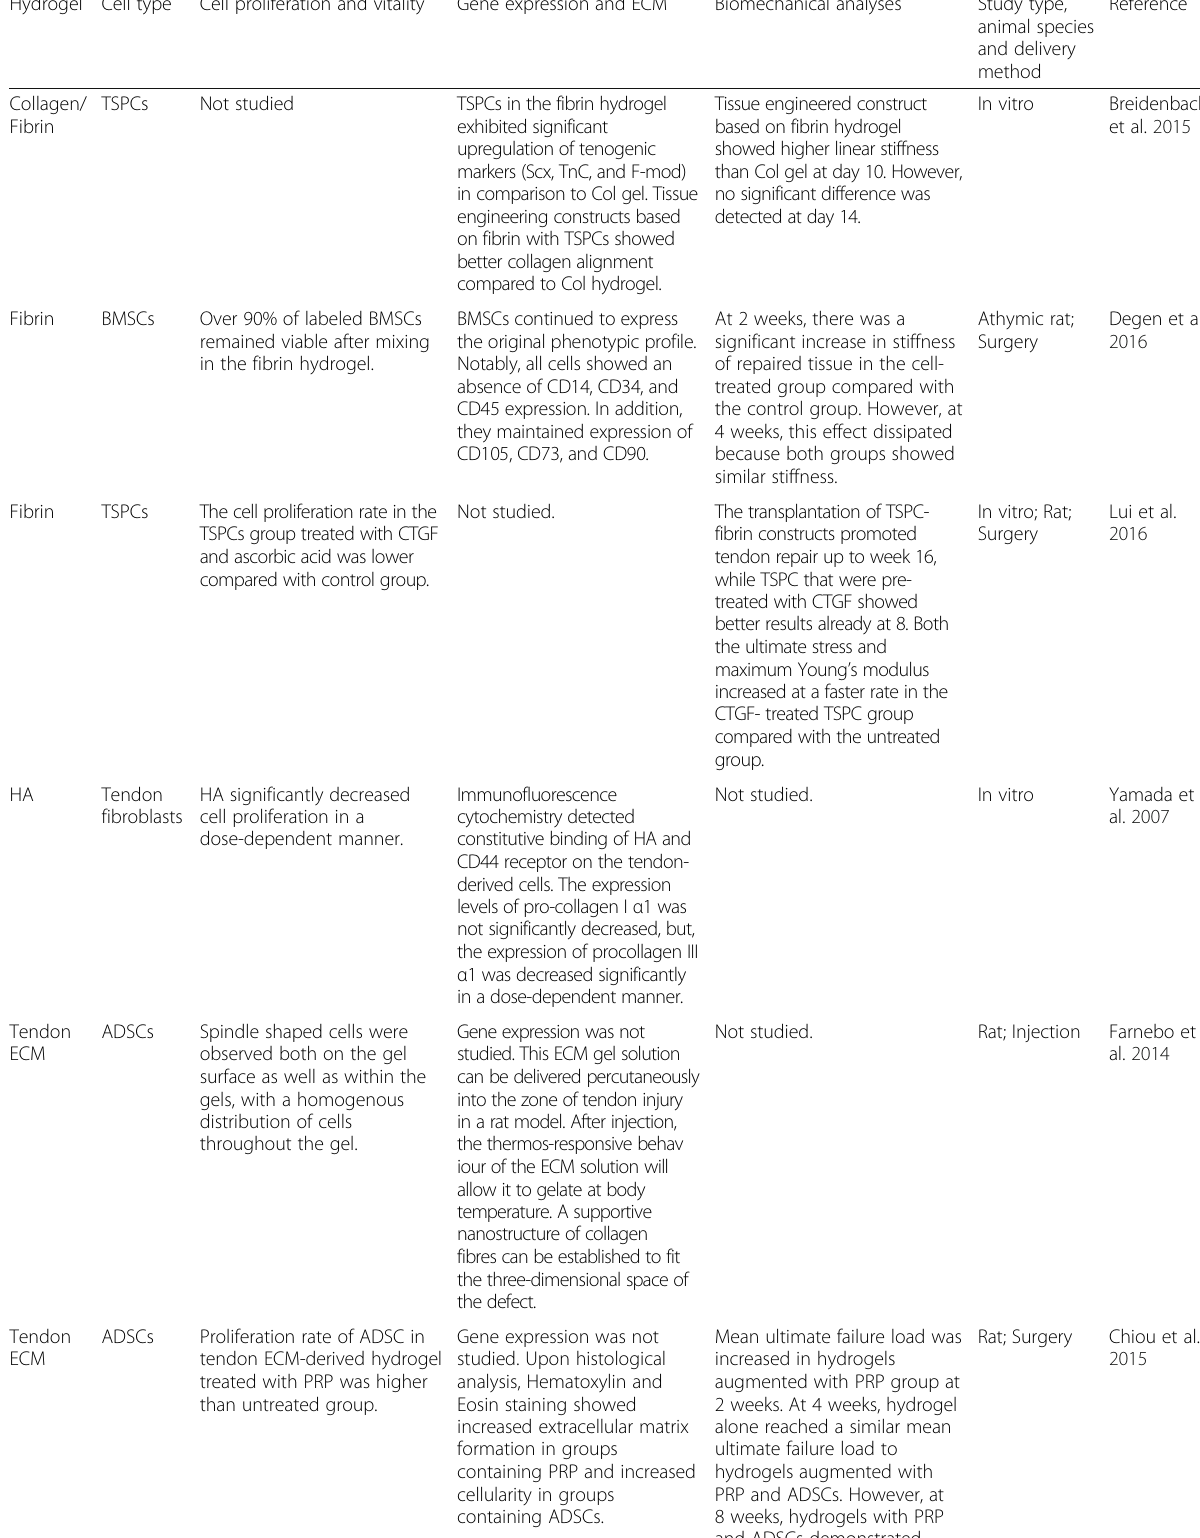
Table 2 Hydrogel-based studies on tendon tissue engineering Hydrogel Cell